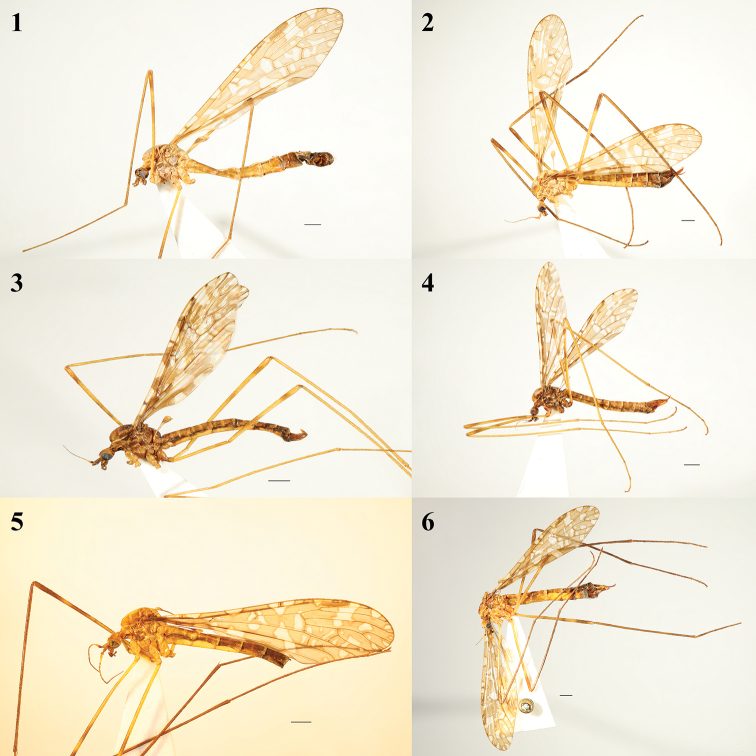
1, 2Epiphragma (Epiphragma) acuminatum sp. nov. 3, 4Epiphragma (Epiphragma) henanensis sp. nov. 5, 6Epiphragma (Epiphragma) longitubum sp. nov. 1, 3, 5 male habitus, lateral view 2, 4, 6 female habitus, lateral view. Scale bars: 1 mm.